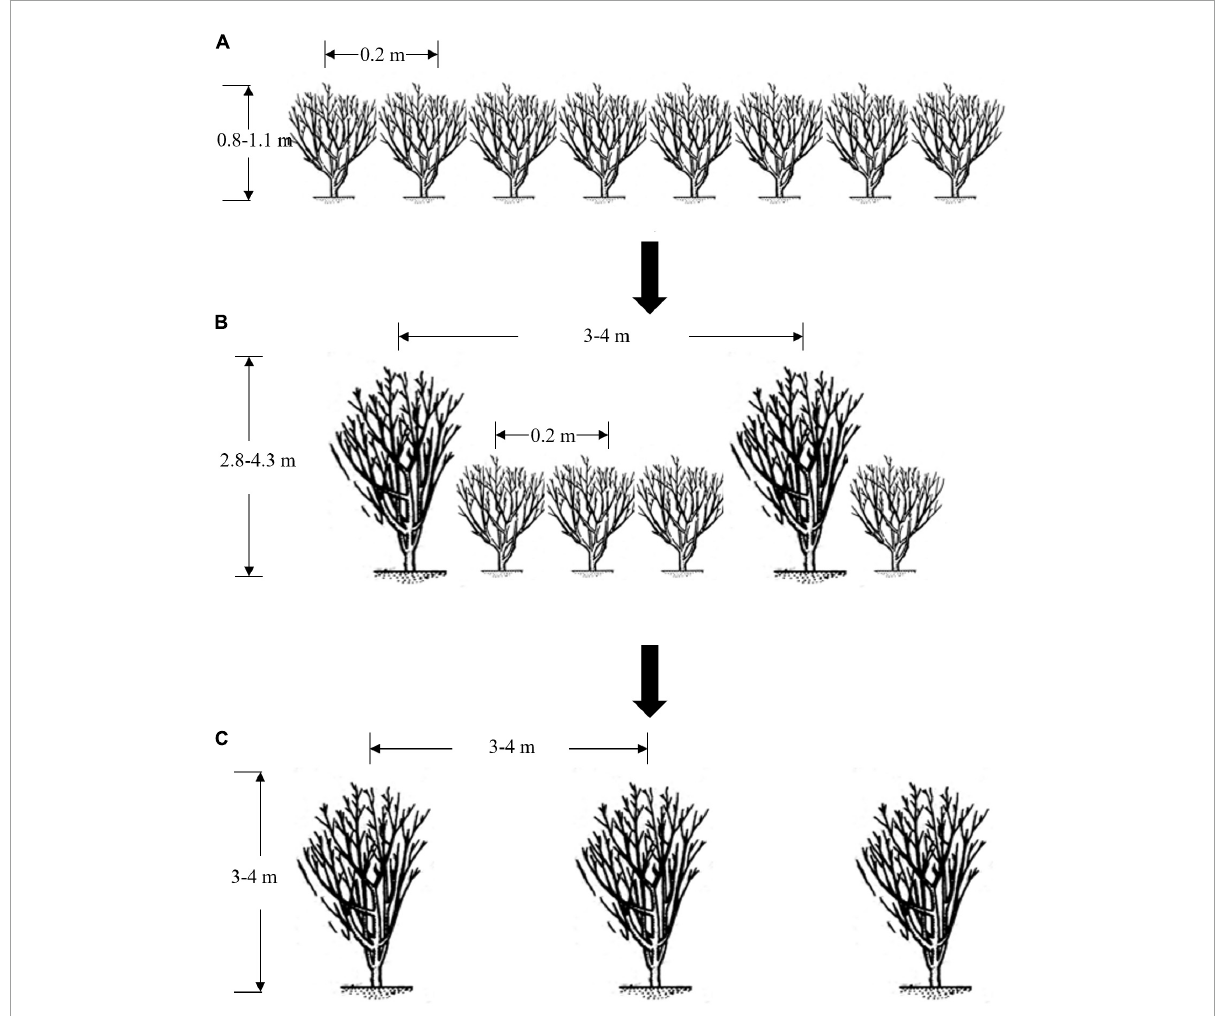
FIGURE1 Scheme for the transformation of a pruned to unpruned tea tree plantation. Tea tree plantations that are pruned (A) ; transforming (B) ; unpruned (C) .